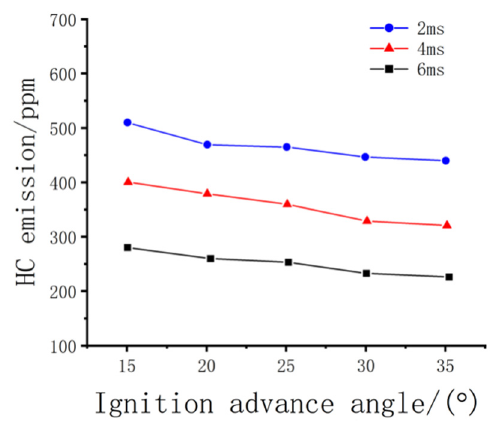
Figure 22. Effect of the ignition parameters on HC emissions.